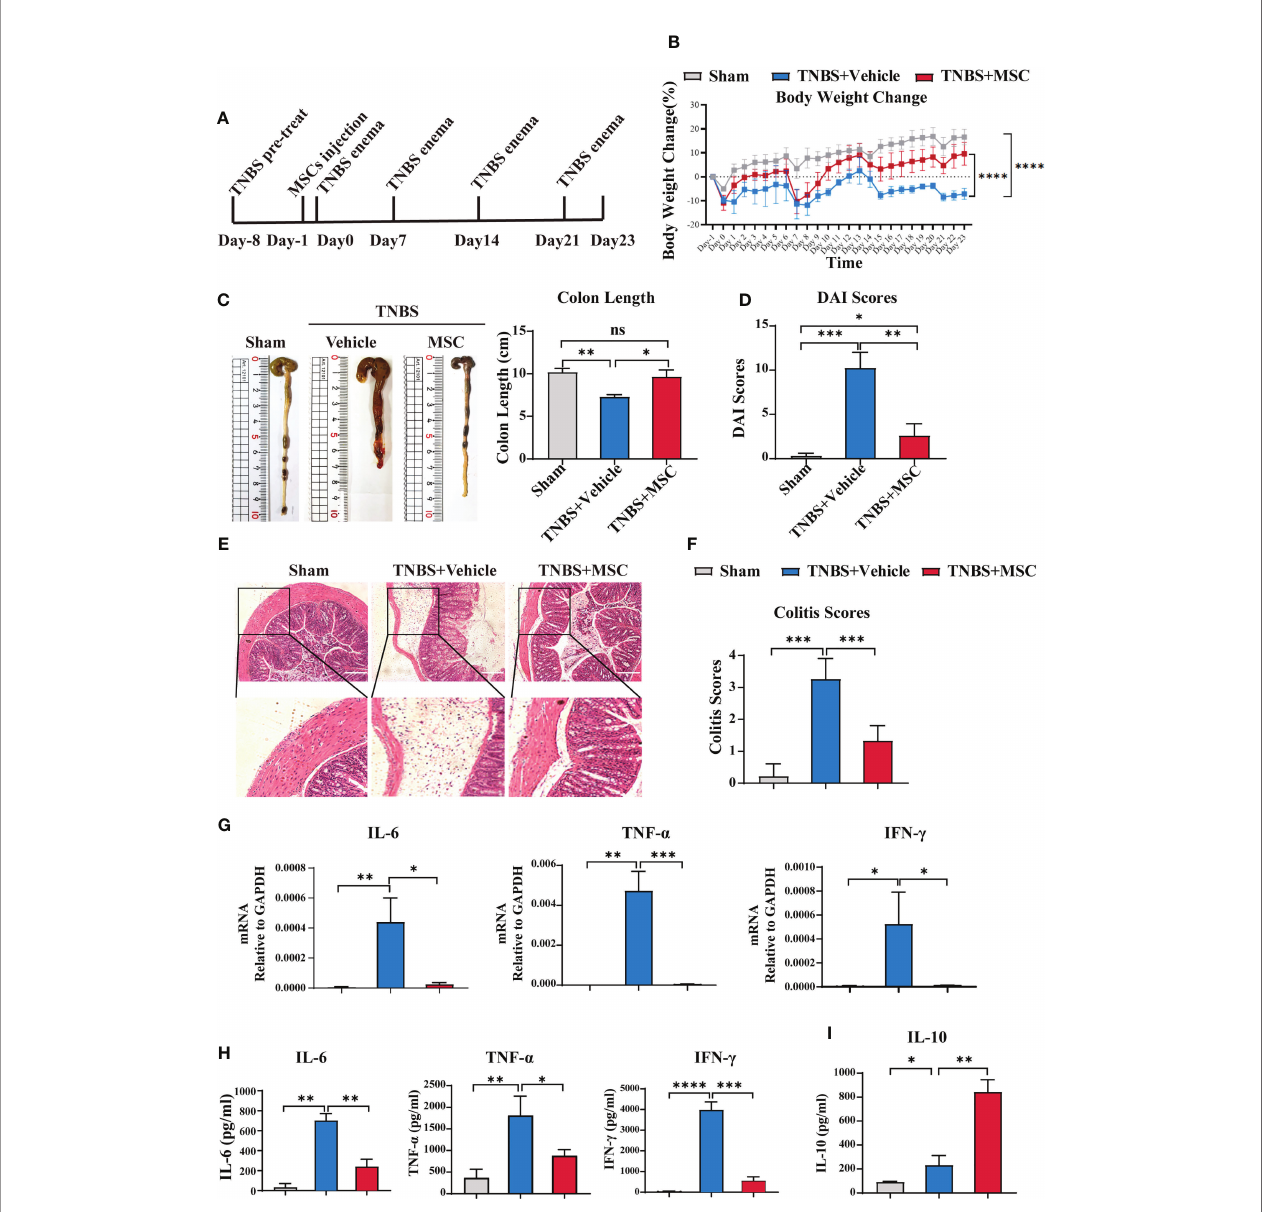
FIGURE 3 | Intraperitoneal delivery of MSCs effectively prevented the recurrence of colitis. A mouse recurrence IBD model was established by four administrations of TNBS (100 m l enema per mouse every 7 days for up to 4 weeks). A single intraperitoneal injection of MSCs was delivered, and the protection of MSCs was investigated. Mice were euthanized at 23 days and collected for analysis. (A) Mouse IBD recurrence model schematic illustration. (B) Comparison of body weight loss. (C) Comparison of colon length. (D) Comparison of DAI combined scores of percentage weight loss, stool consistency, and bleeding. (E) Histological examination of colon cross sections via H&E staining and (F) histological scoring. (G) Colon tissue was collected, and total RNA was extracted. The expression level of proin fl ammatory cytokines was evaluated in the colons of mice from the sham, TNBS-induced, and MSC treatment groups through RT – PCR. (H) Colon tissue was collected, and the expression levels of proin fl ammatory cytokines in colon homogenate were detected by ELISA. (I) Peritoneal fl uid was harvested, and the IL-10 level was determined by ELISA. Data are presented as the means ± SD, n ≥ 3. not signi fi cant (ns) p ≥ 0.05, *p < 0.05, **p < 0.01, ***p < 0.001, ****p <